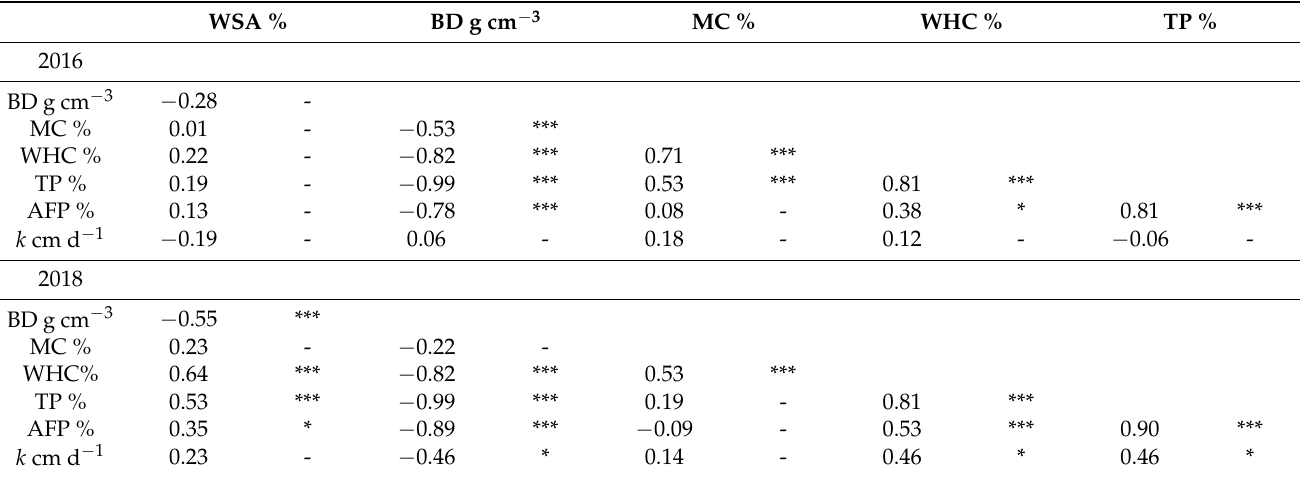
Table 6. Pearson’s correlation coefficients (r) between soil physical properties in 2016 and 2018; n = 48 per year.